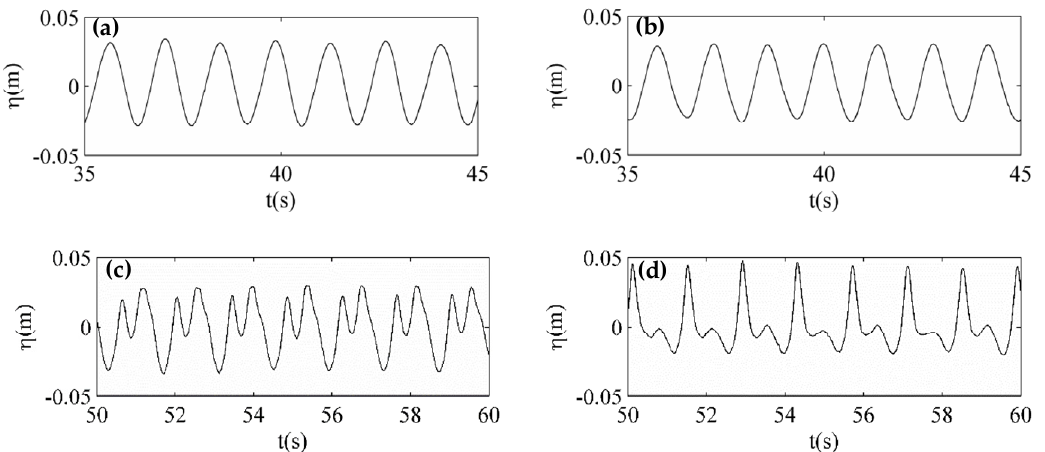
Figure 5. The time series of surface elevations in the front ( a ) WG1 and ( b ) WG2 and in the rear ( c ) WG3 and ( d ) WG4 of the plate under regular waves over a flat bottom. (d = 0.14 m, T = 1.4 s and H / h = 0.1.).